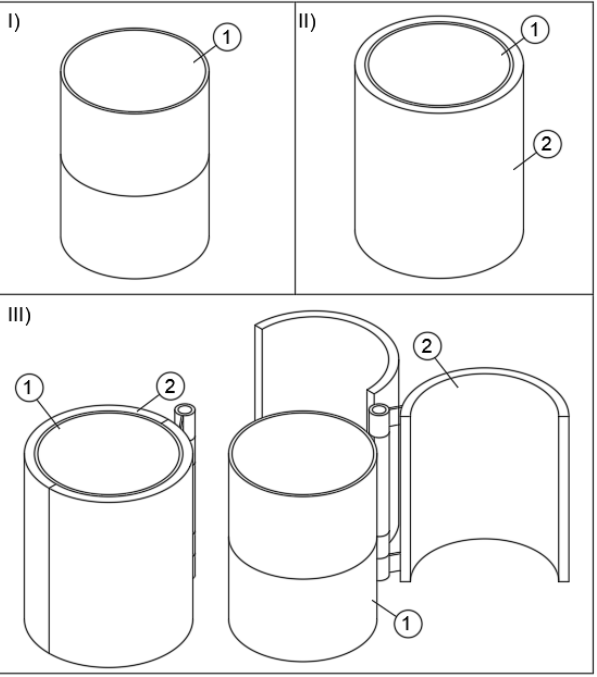
Figure 2. Carbonization kiln configurations: ( I ) fixed sidewall composed of material 1; ( II ) fixed side wall composed of materials 1 and 2; ( III ) pivoting sidewall for the heating stage with materials 1 and 2, and the cooling stage with material 1.